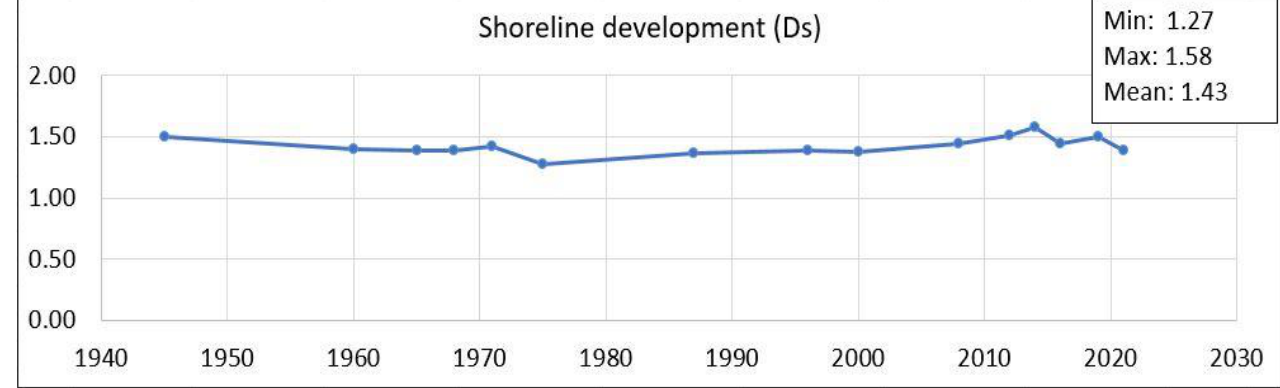
Figure 7. Lagoon’s shoreline development index fluctuations during the study period.